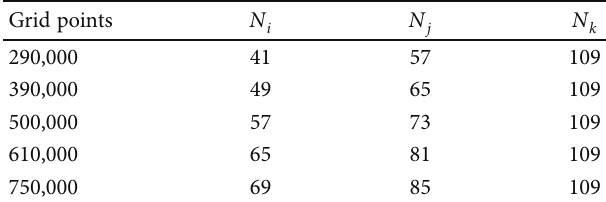
Figure 6: O4H topology. Table 2: Number of grid